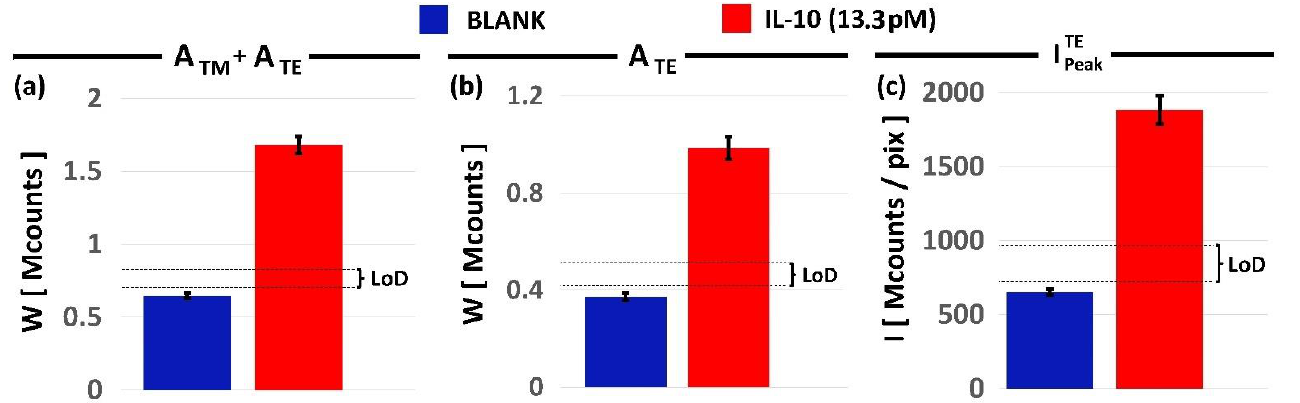
Figure 3. Histograms of fluorescence integrated and intensity fluorescence for the blank (blue bars) and IL-10 (13.3 pM) (red bars) related to the analysis of three parameters: ( a ) A TM + A TE ; ( b ) A TE ; ( c ) I TE cases, the estimated LoD